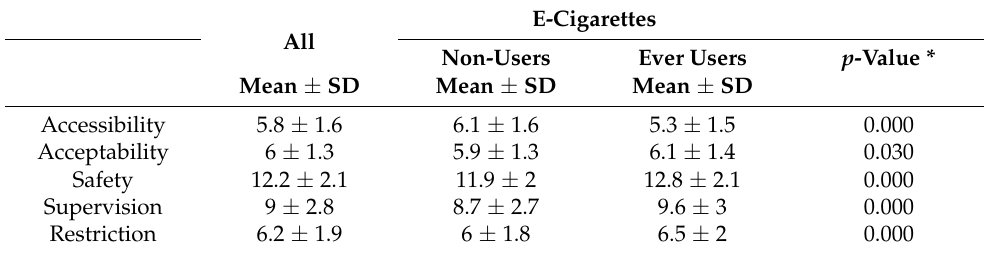
Table 5. Study Participants’ Attitude toward E-cigarettes, N = 679.